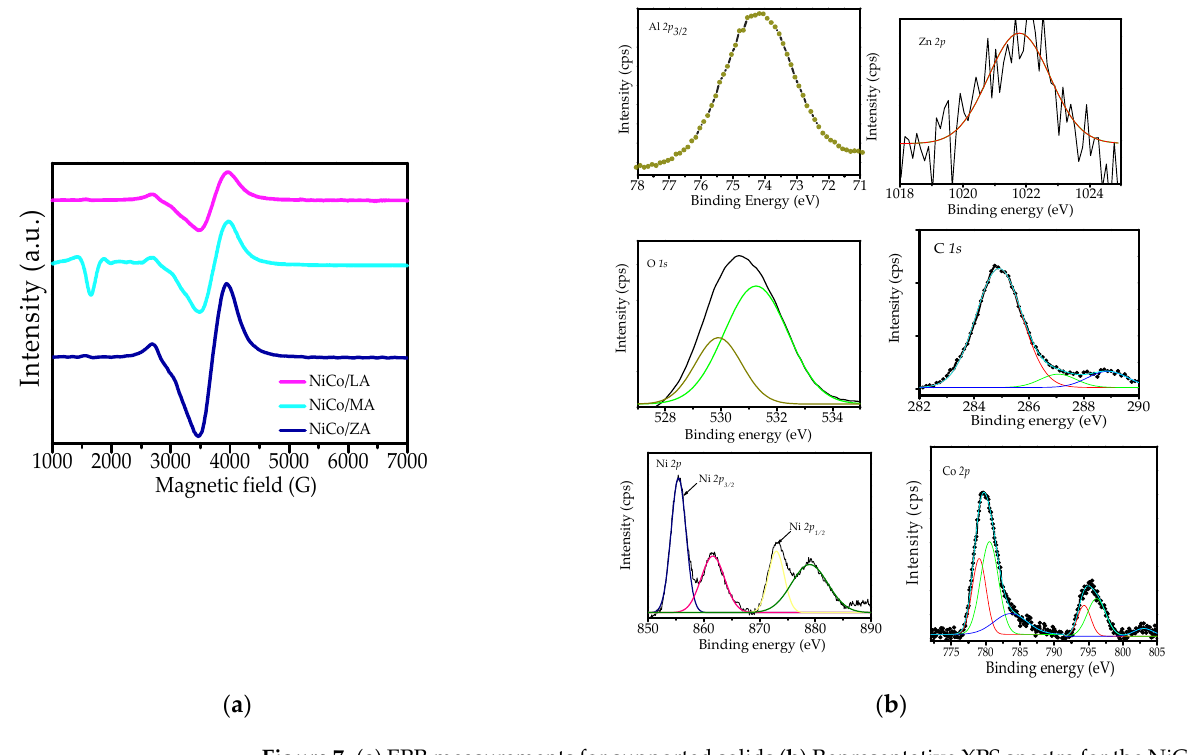
Figure 7. ( a ) EPR measurements for supported solids ( b ) Representative XPS spectra for the NiCo/ZA supported solid.